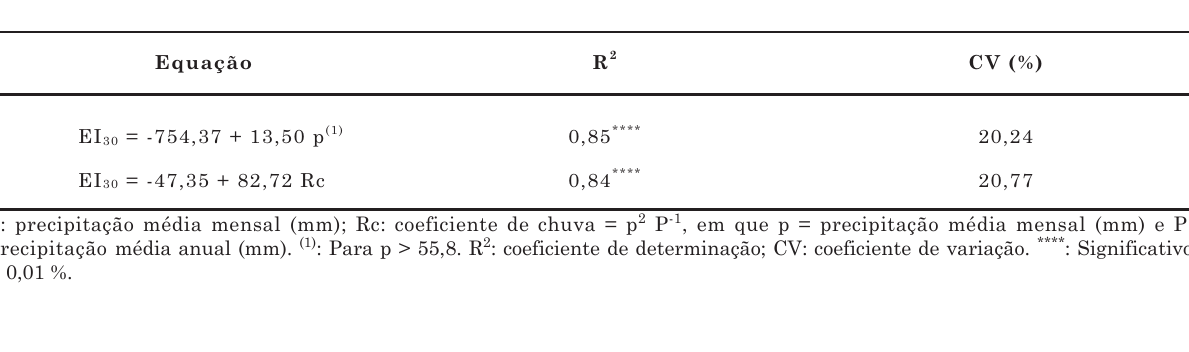
vs. coeficiente 30